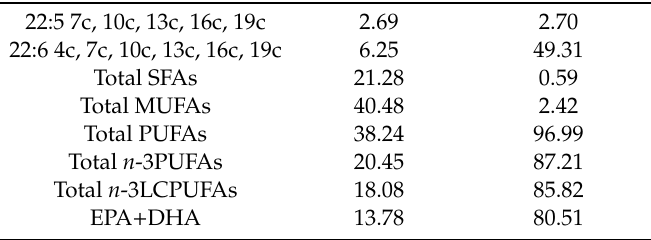
*Abbreviationsemployed: DHA(docosahexaenoicacid),EPA(eicosapentaenoicacid),FA(fattyacid),SFAs(saturated fatty acids), MUFAs (monounsaturated fatty acids), RCSO (refined commercial salmon oil), n-3LCPUFAs (n-3 long